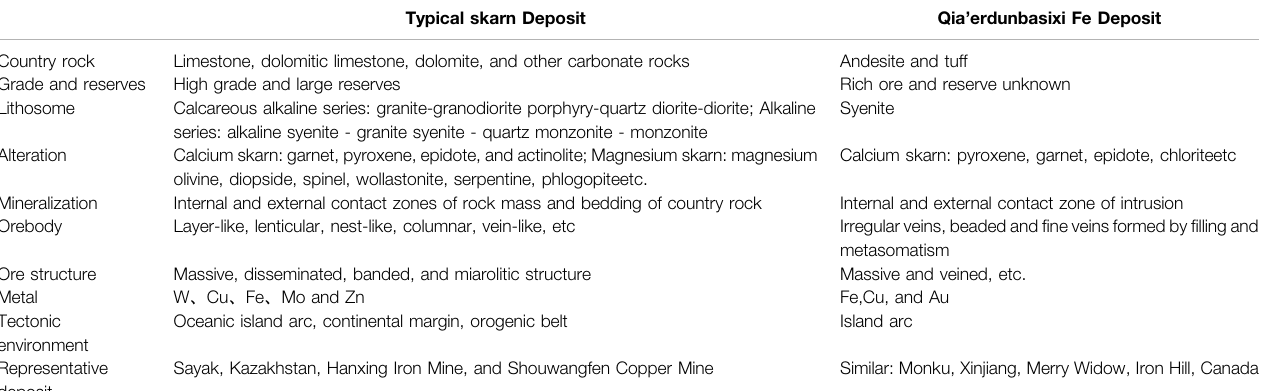
TABLE 5 | Comparison between the Qia ’ erdunbasixi Fe deposit and a typical skarn deposit (Meinert et al., 2005; Chang et al., 2019).